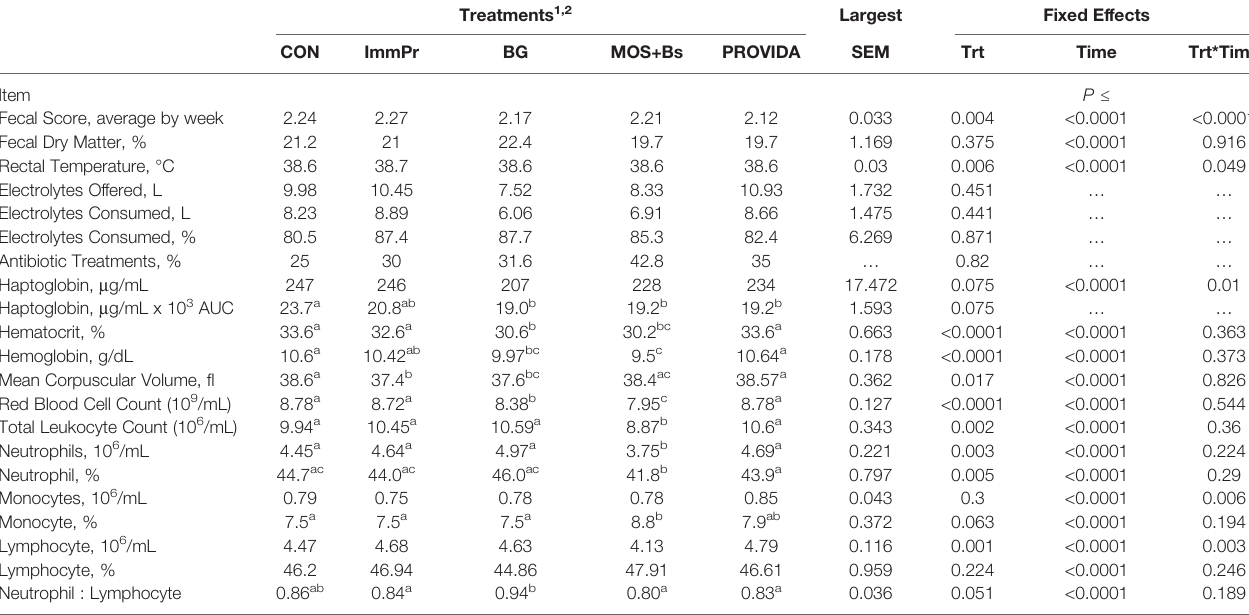
TABLE 4 | The effect of treatments on health measurements in high-risk Holstein dairy calves. Treatments 1,2 Largest Fixed Effects